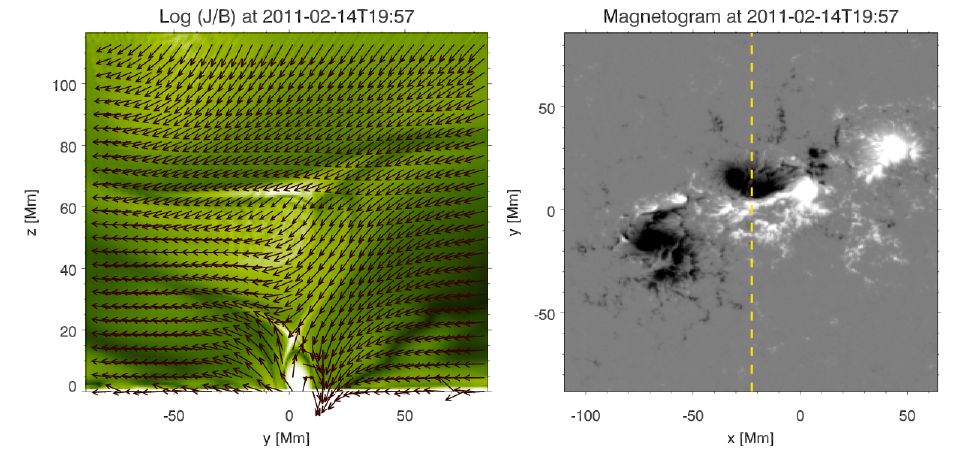
Figure 64: Still from a movie showing Left: Distribution of normalized current density (j/B, green) and magnetic field orientation (arrows) at a vertical cut along the dashed line shown in the right panel. Right: Magnetogram sequence (remapped from SDO/HMI data) used for the data-driven simulation of NOAA AR 11158 by Cheung and DeRosa (2012). Image reproduced with permission, copyright by AAS. (To watch the movie, please go to the online version of this review article at http://www.livingreviews.org/ lrsp-2014-3